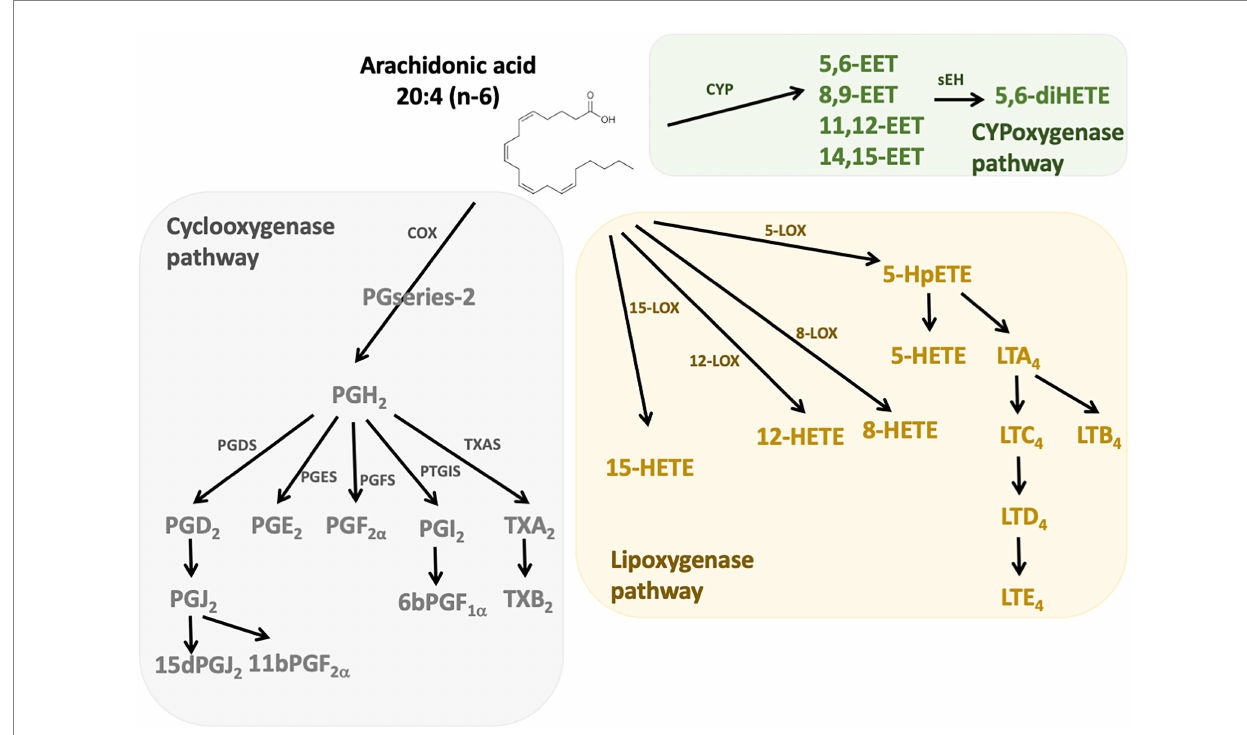
FIGURE 1 n-6 Oxylipins derived from arachidonic acid. The metabolism of PUFAs is a complex process involving several enzymes of desaturation, elongation, and β -oxidation. n-6 oxylipins are synthesized from arachidonic acid (ARA) through three major pathways, the first depending on cyclooxygenase (grey), the second on lipoxygenase (yellow), and the third on cytochrome P450 (CYP) monooxygenase activities (green). COX, cyclooxygenase; LOX, lipoxygenase; CYP, cytochrome P450; PGFS, prostaglandin F synthase; PGDS, prostaglandin D synthase, PGES, prostaglandin E synthase; PTGIS, prostaglandin I synthase; TXAS, thromboxane A2 synthase.